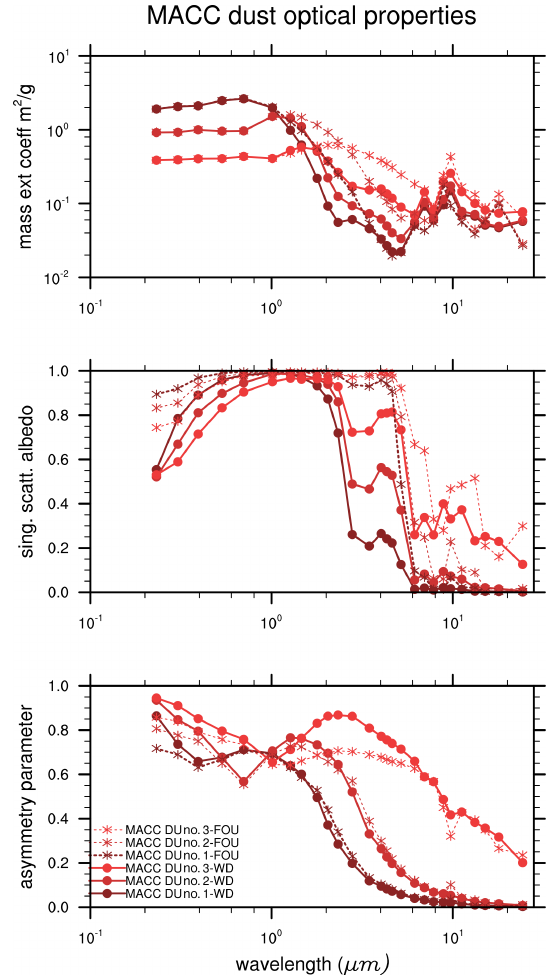
Figure 1. Dust optical properties used in the MACC system: mass extinction coefficient (top), single-scattering albedo (middle) and asymmetry parameter (bottom) as a function of wavelength for the three dust bins (no. 1 is the smallest bin, no. 3 is the largest), com- puted using the refractive indices of Woodward (2001) and Fouquart et al.